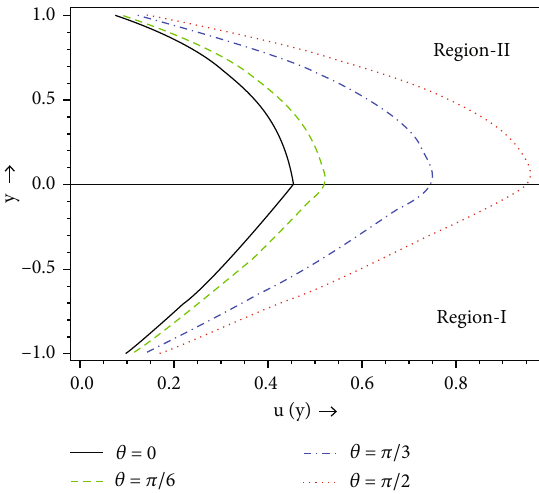
Figure 5: Variation of velocities with the angle of inclination ð θ Þ .